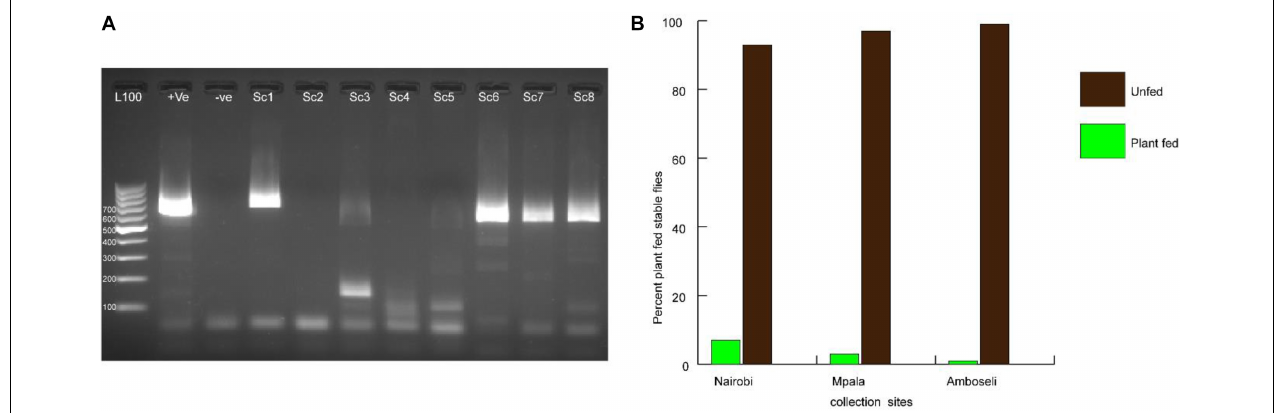
FIGURE 1 | Amplification of target chloroplast marker for identification of plant sources of nectar. (A) Electrophoresis of PCR amplicons resolved through 1% agarose gel stained with ethidium bromide for visualization of DNA bands. Positive ( + ve) control was fall army warm larvae fed on maize; − ve control was PCR Mastermix with water used as template. Lanes Sc1–Sc8 represent Stomoxys calcitrans DNA samples amplified for chloroplast DNA. (B) Graph showing the percent plant-fed stable flies collected from three different sampling sites.